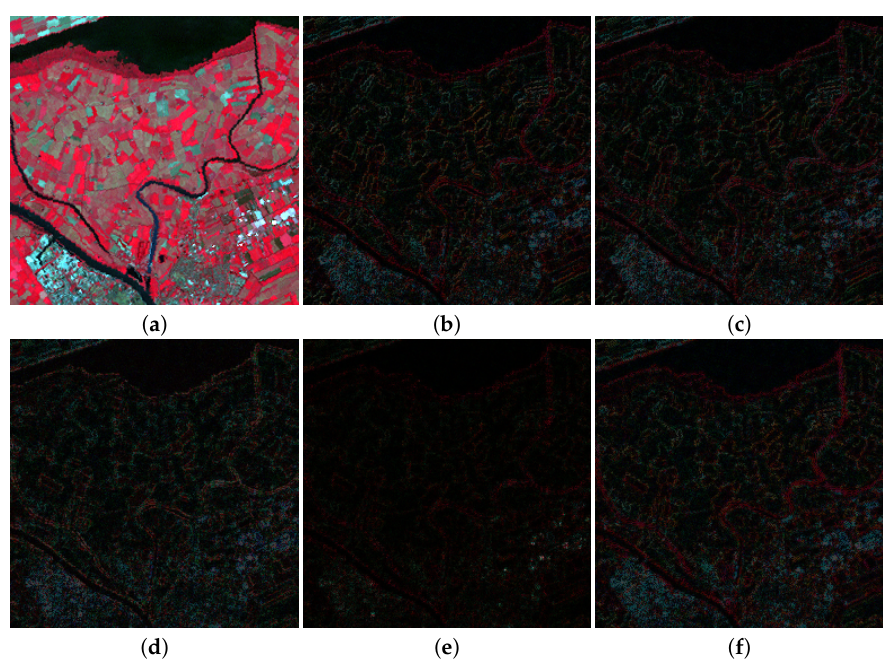
Figure 6. ( a ) Ground truth 256 × 256 image from Figure 2c. The normalized maximum absolute error images for the following methods: ( b ) PRACS, ( c ) MTF-GLP-CBD, ( d ) TV, ( e ) (cid:96) 1 and ( f ) log.